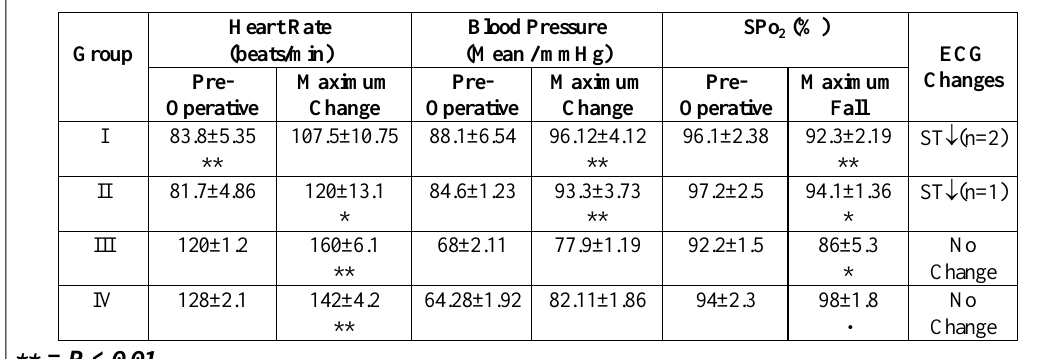
Table III : Physiological Changes in different groups